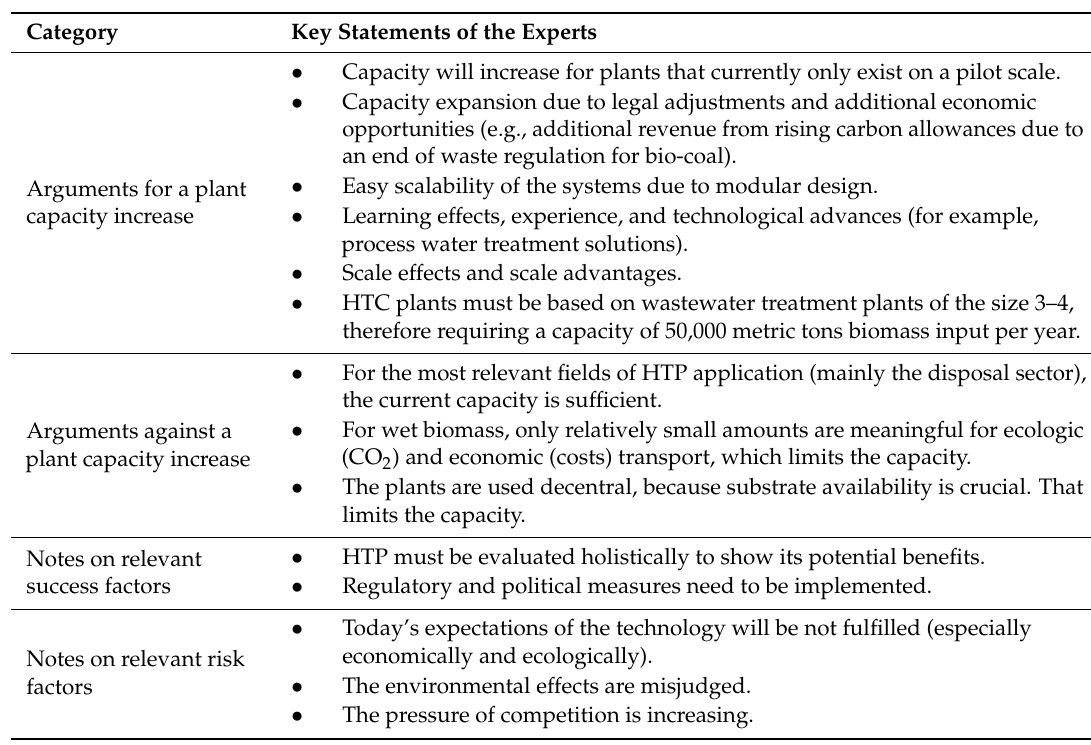
Table A3. Summarized comments and hint of experts in the Delphi